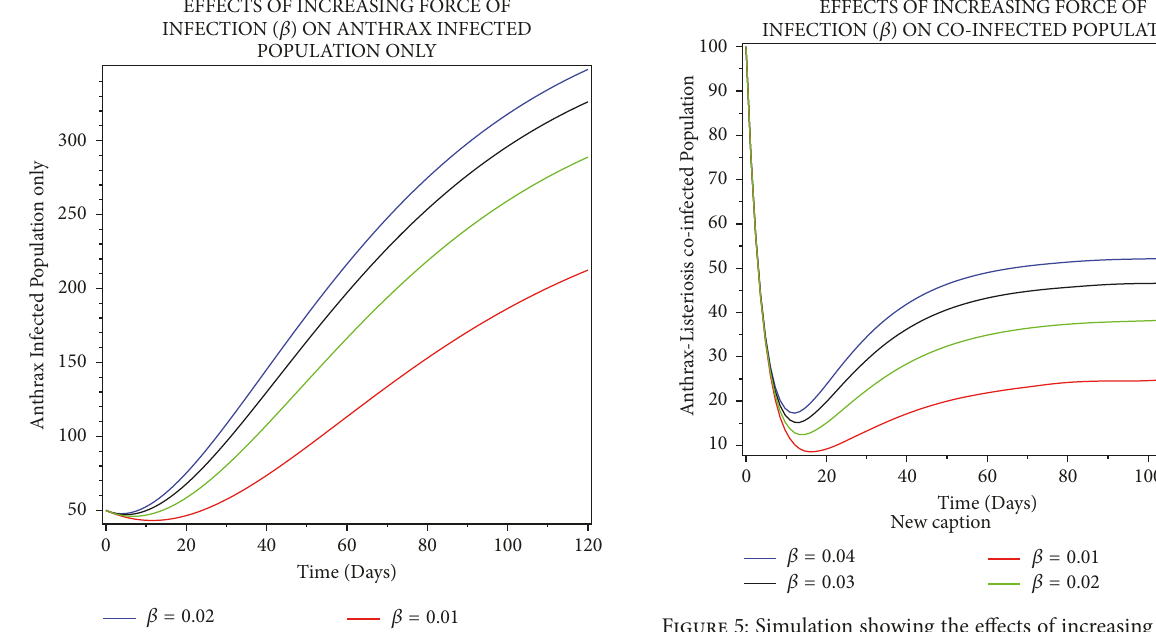
Figure 5: Simulation showing the effects of increasing the force of infection on Anthrax infected population